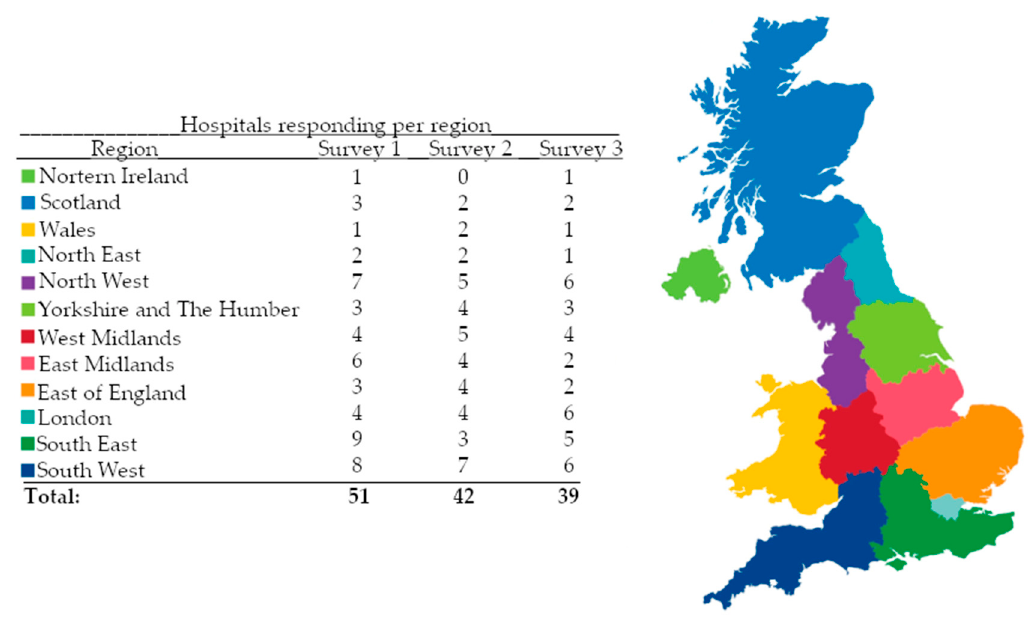
Figure 1. Number of hospitals responding to each survey by region of the United